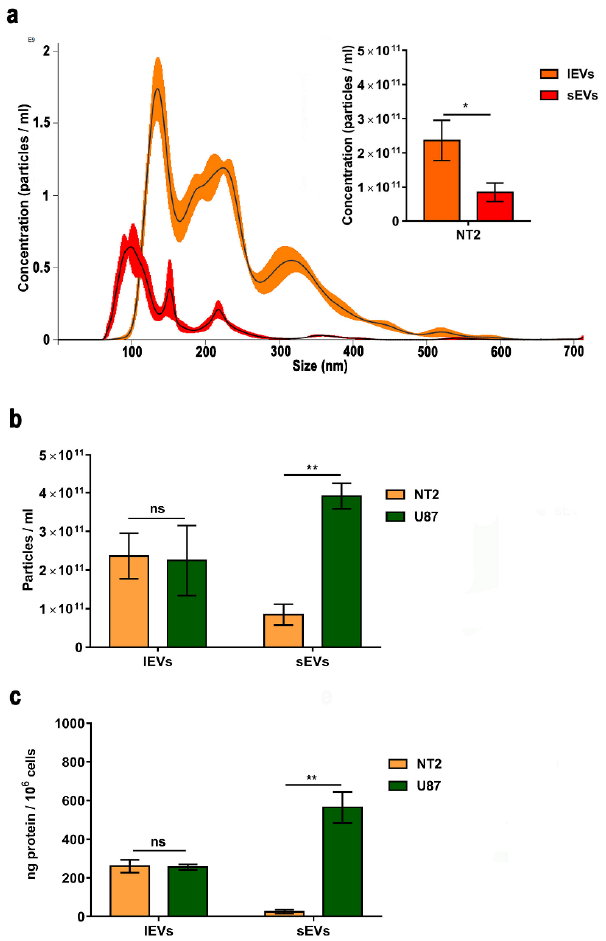
Figure 3. Extracellular vesicle quantification. ( a ) Nanoparticle tracking analysis (NTA) of NTERA2 extracellular vesicles. Representative image of size distribution of small extracellular vesicles or sEVs (red line) and large extracellular vesicles or lEVs (orange line). The inset histogram shows the mean ± standard mean error of sEV and lEV concentration. ( b , c ) Comparison of the concentration of particles measured by NTA ( b ) and the protein yield ( c ) in sEV and lEV samples isolated from NTERA2 and U87 cancer cells. The volume of resuspension is kept constant. To determine particle concentration, five and two different samples have been analyzed for NTERA2 and U87, respectively. For each sample, five experiment videos of 60 s duration were analyzed. To determine protein yield six and three different experiments have been analyzed for NTERA2 and U87, respectively. ns not significant, * p < 0.05; ** p < 0.01.